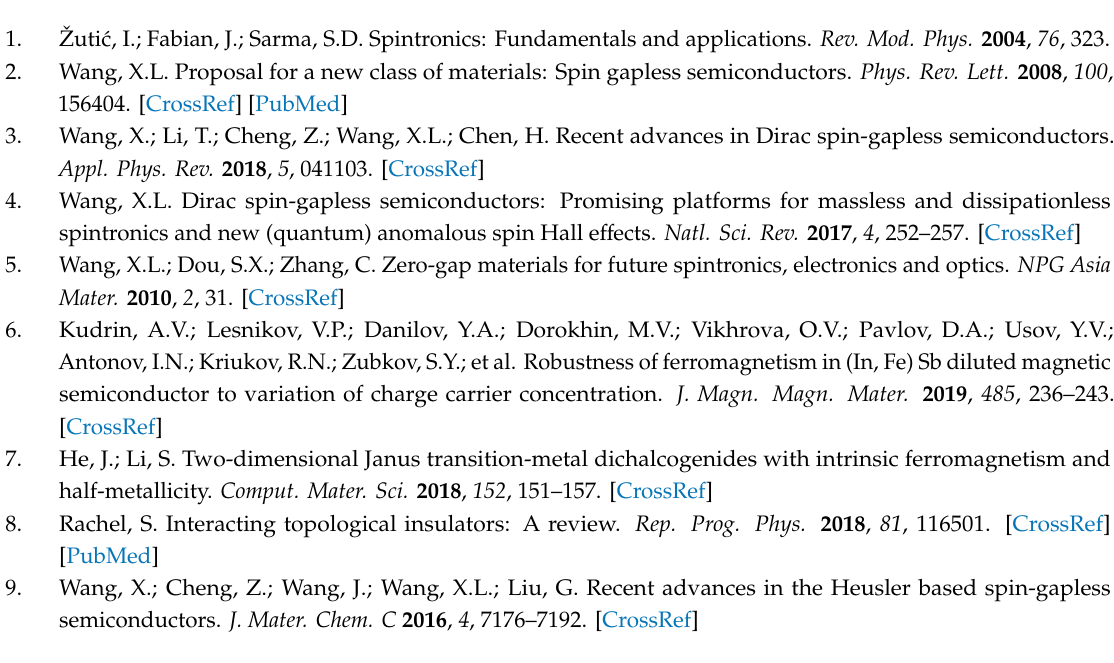
Figure S1: (a) Front and (b) side views of lattice structure of rhombohedral-type PdF 3 bulk, Figure S2: Geometric structure of PdF 3 -Ga 2 O 3 -PdF 3 magnetic tunnel junction (MTJ), Figure S3: Band structures of PdF 3 bulk calculated based on the PBE + U method. Here, we assessed the influence brought by Hubbard U from 1 eV to 4 eV for Pd-4 d orbits, Figure S4: Band structure of PdF 3 bulk under MBJGGA calculation within VASP software, Figure S5: Band structure of PdF 3 bulk calculated based on the PBE functional with consideration of the SOC e ff ect, Figure S6: Band structures of PdF 3 bulk under di ff erent pressures. These results were calculated based on the PBE functional, Figure S7: Equilibrium-state transmission spectrum in parallel configuration for PdF 3 -based MTJ. (b) Equilibrium-state transmission spectrum in anti-parallel configuration for PdF 3 -based MTJ, Figure S8: Non-equilibrium transmission spectrum versus electron energy at a fixed bias voltage for PdF 3 -based